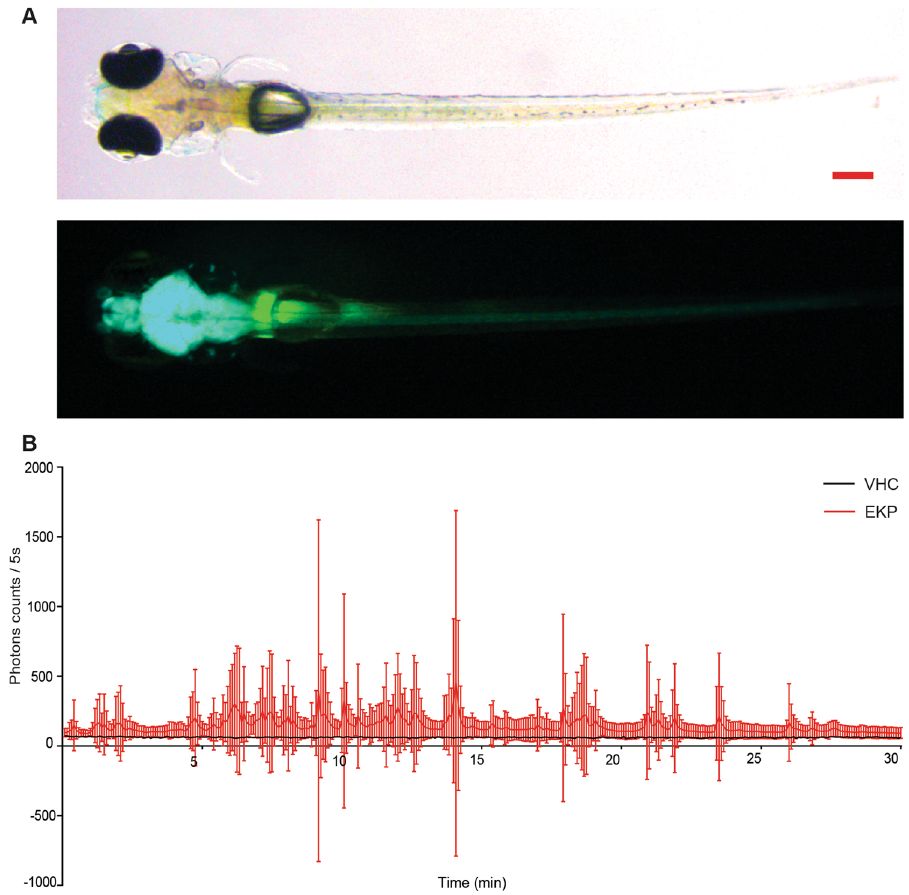
Figure 4. Neuroluminescence recording of Tg(elavl3:GA) zebrafish exposed to EKP. ( A ) Bright field (upper) and fluorescence (lower) micrographs of 7 dpf Tg(elavl3:GA) larva (scale bar: 0.20 mm) ( B ) Photon emission of 7 dpf larvae exposed to VHC (black line) or EKP (400 µ M) (red line), after a 20 h incubation to CLZN-h (40 µ M) exposure during a 30-min recording period. The total photon emission (y-axis) is counted per 5-second (sec) interval (x-axis). Results are expressed as mean ± s.d. of 18 independent experiments. For each experiment a group of three larvae was